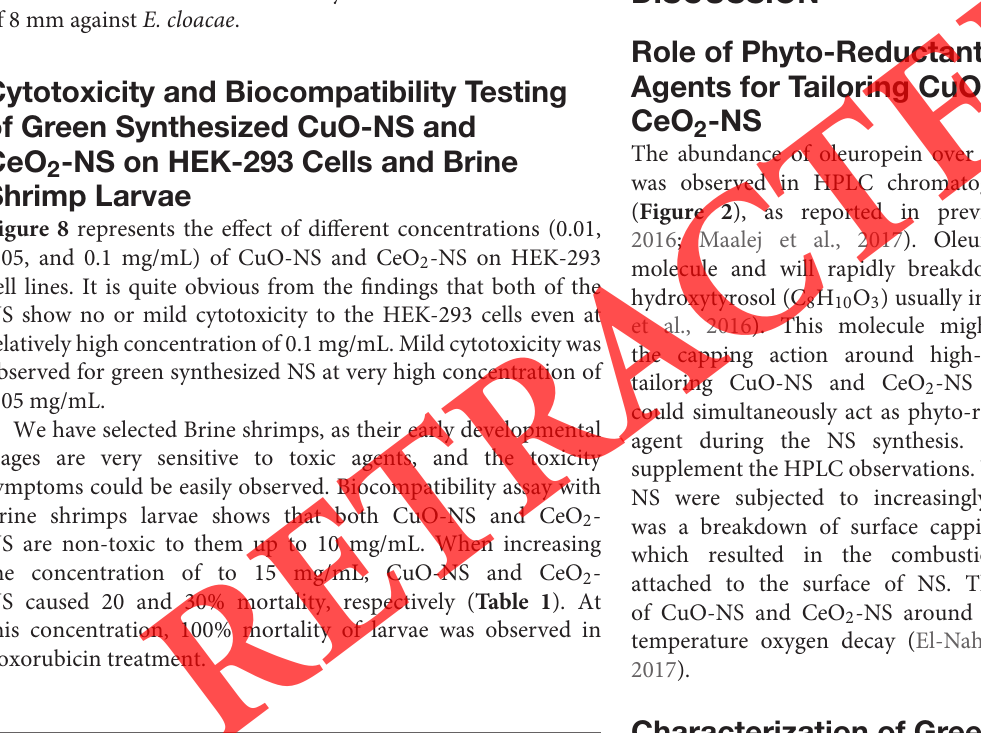
of 8 mm against E. cloacae .